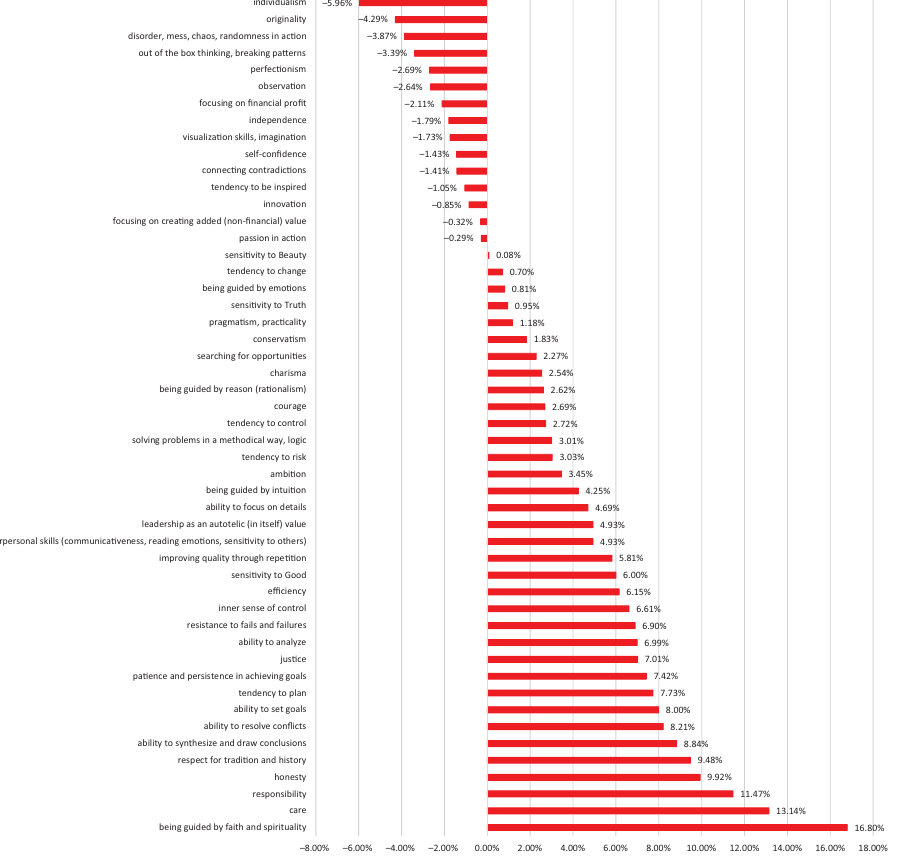
Figure 2. Perception of the 50 features of an artist’s identity by artistic versus non-artistic individuals (source: created by